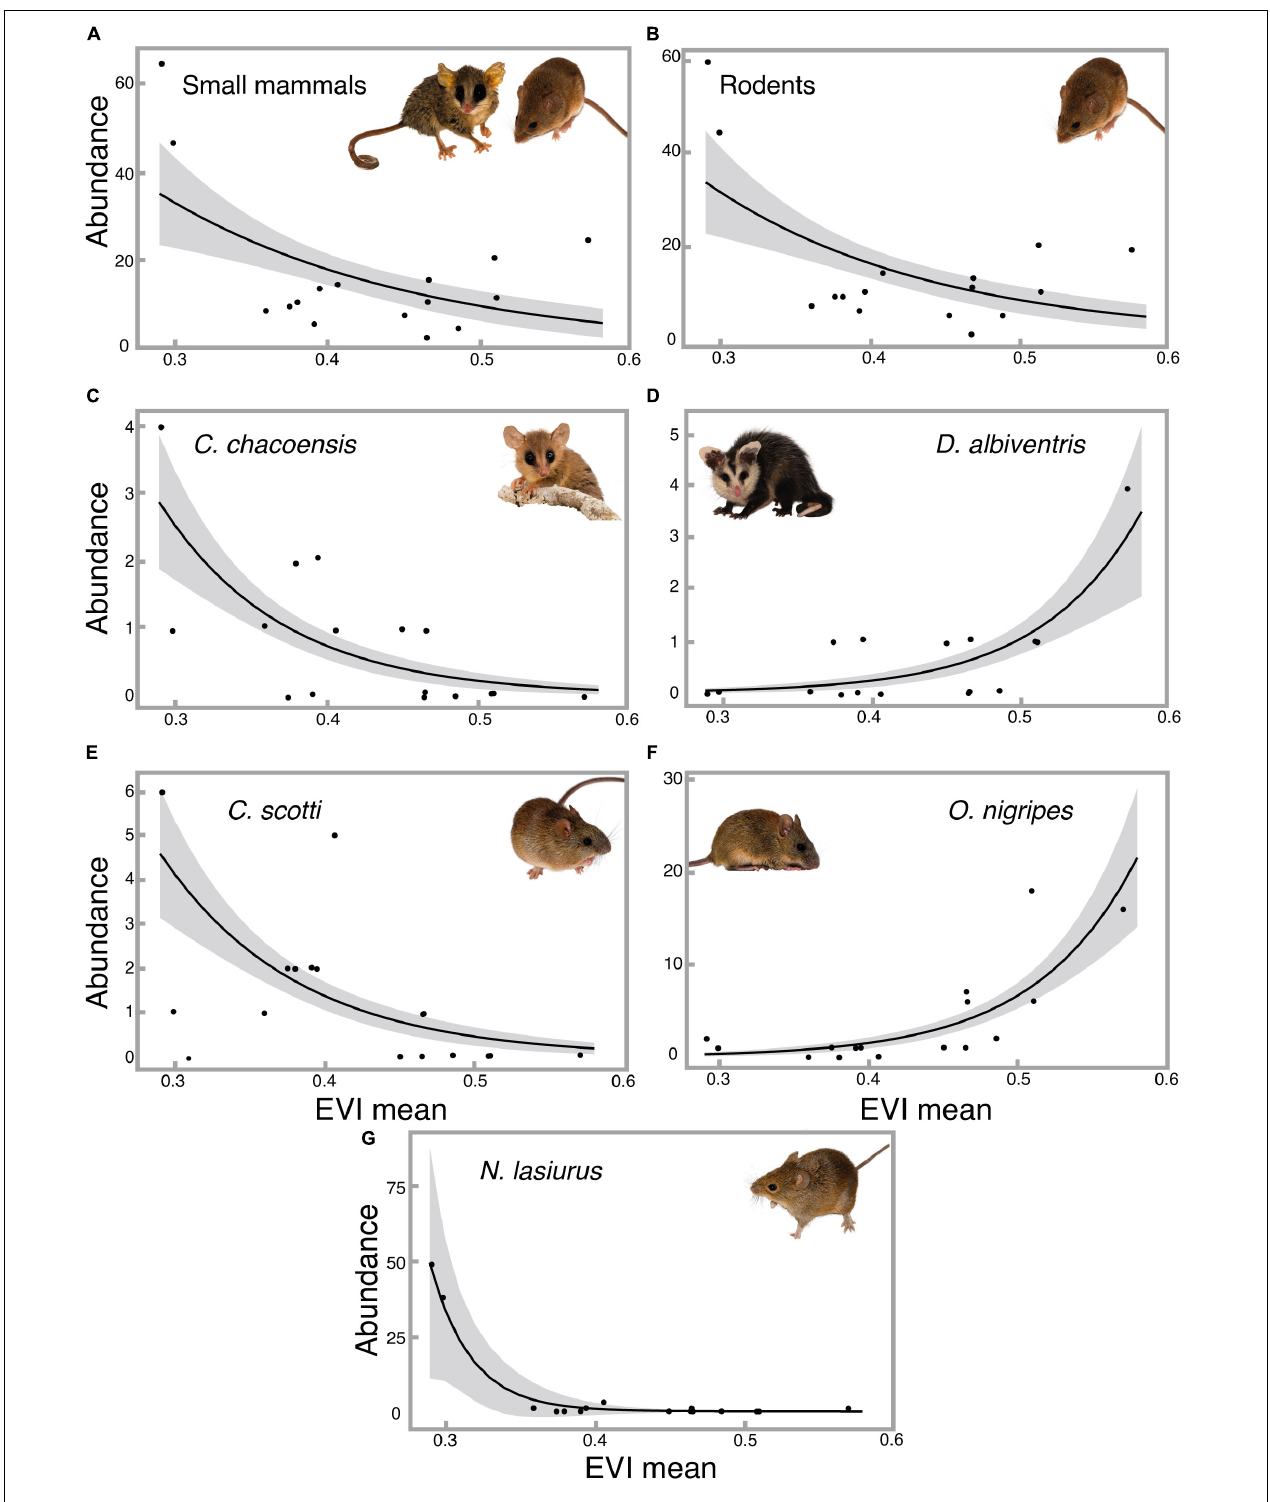
FIGURE 6 | Predicted effect of mean EVI on the (A) total abundance of small mammals, (B) abundance of rodents, and abundance of different species: (C) Cryptonanus chacoensis , (D) Didelphis albiventris , (E) Cerradomys scotti , (F) Oligoryzomys nigripes , and (G) Necromys lasiurus estimated by generalized linear models for the sampling units in SBES. The shadows represent the 95% confidence intervals. All photos by Bruno Ferreto Fiorillo.